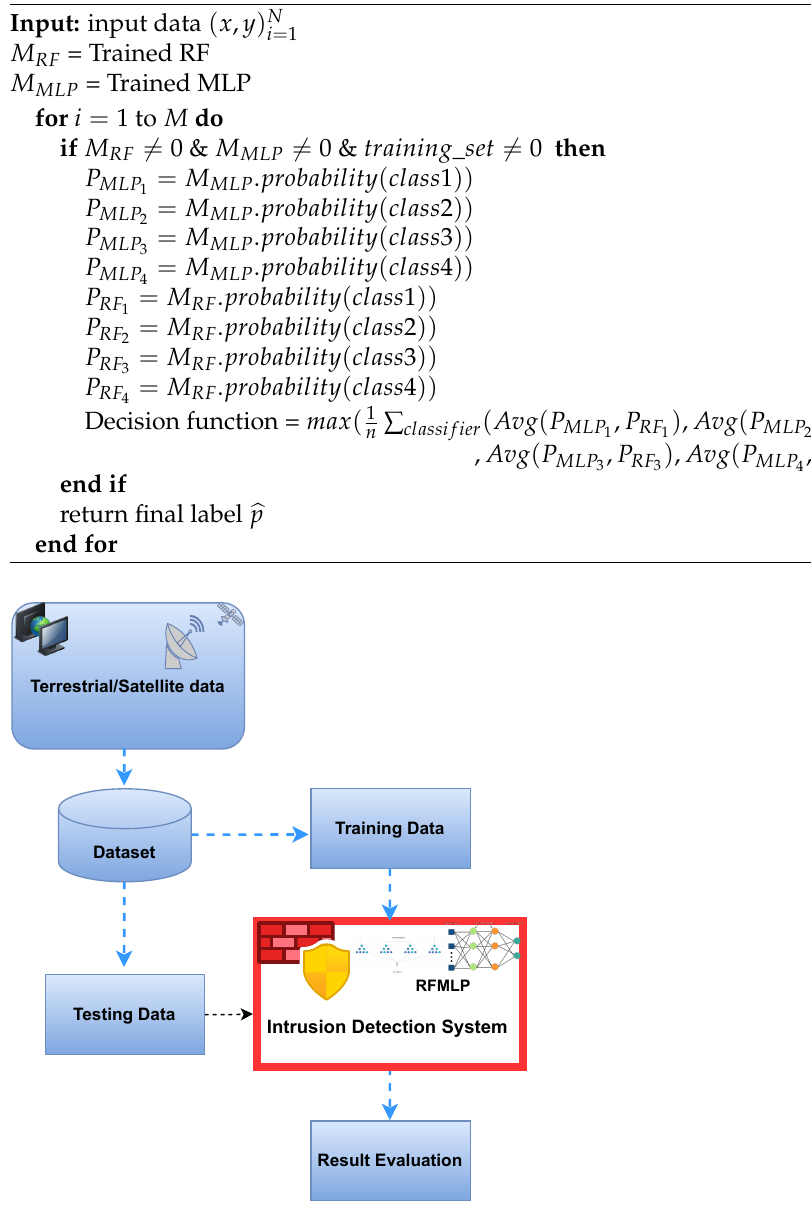
Figure 1. Architecture of the proposed methodology for DDoS attack